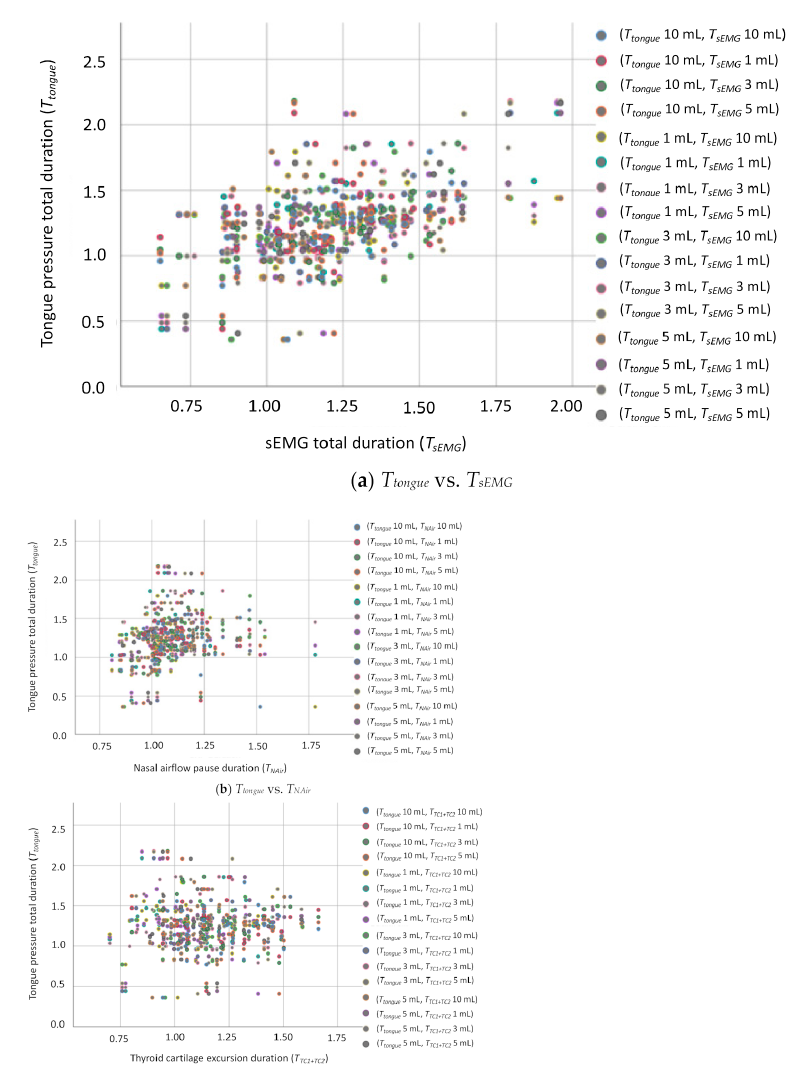
Figure 16. Grouped scatter plots of the parameter T tongue with T sEMG , T NAir , and T TC1+TC2 : ( a ) T tongue vs. T sEMG , ( b ) T tongue vs. T NAir , ( c ) T tongue vs. T TC1+TC2